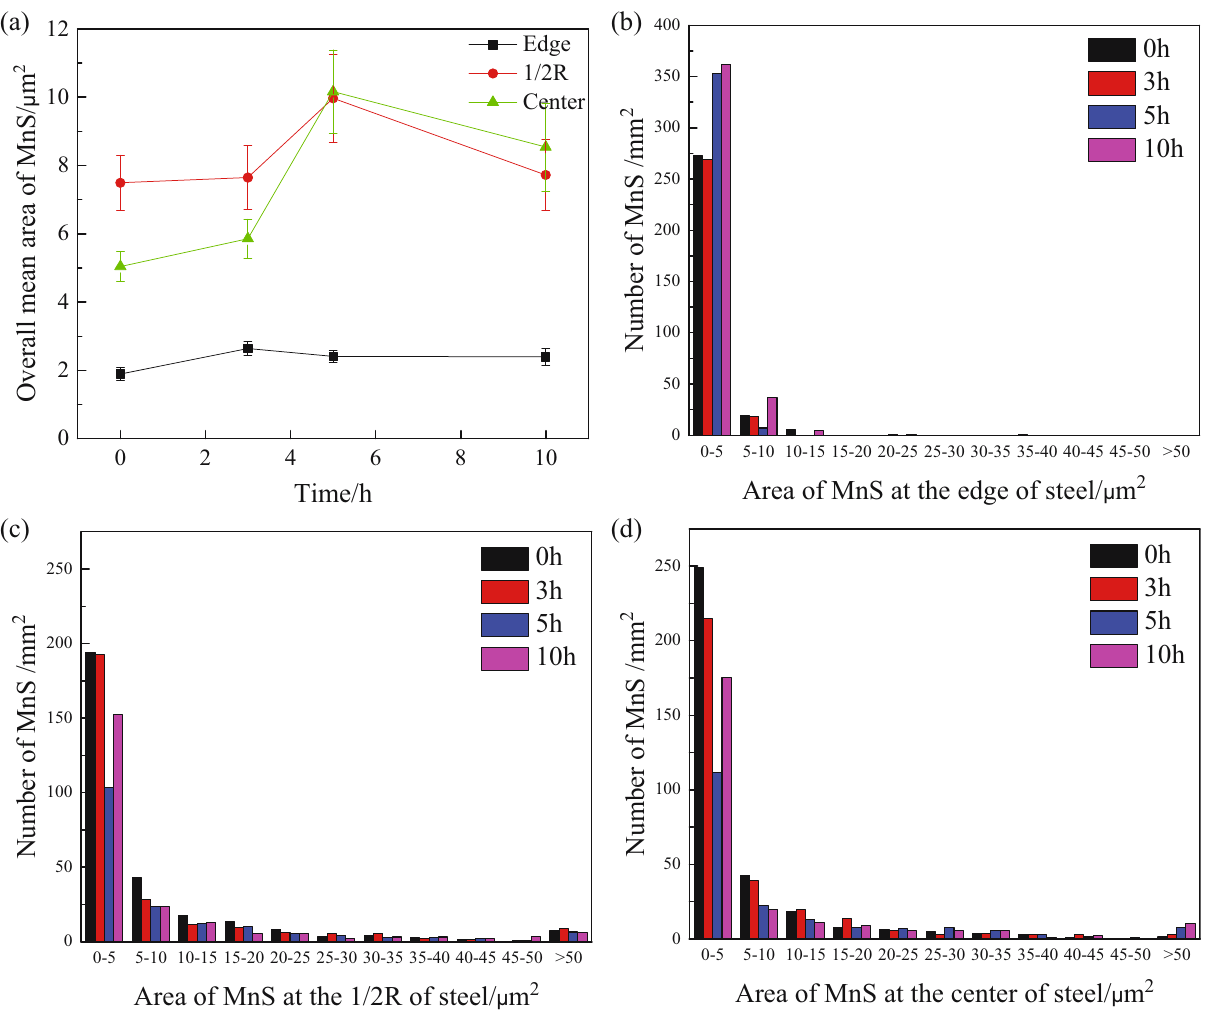
Figure 7: Overall mean area and area distribution of MnS at different positions without and with homogenization at 1,050°C; ( a ) overall mean area of MnS, ( b – d ) area distribution of MnS at the edge, 1/2R and center,